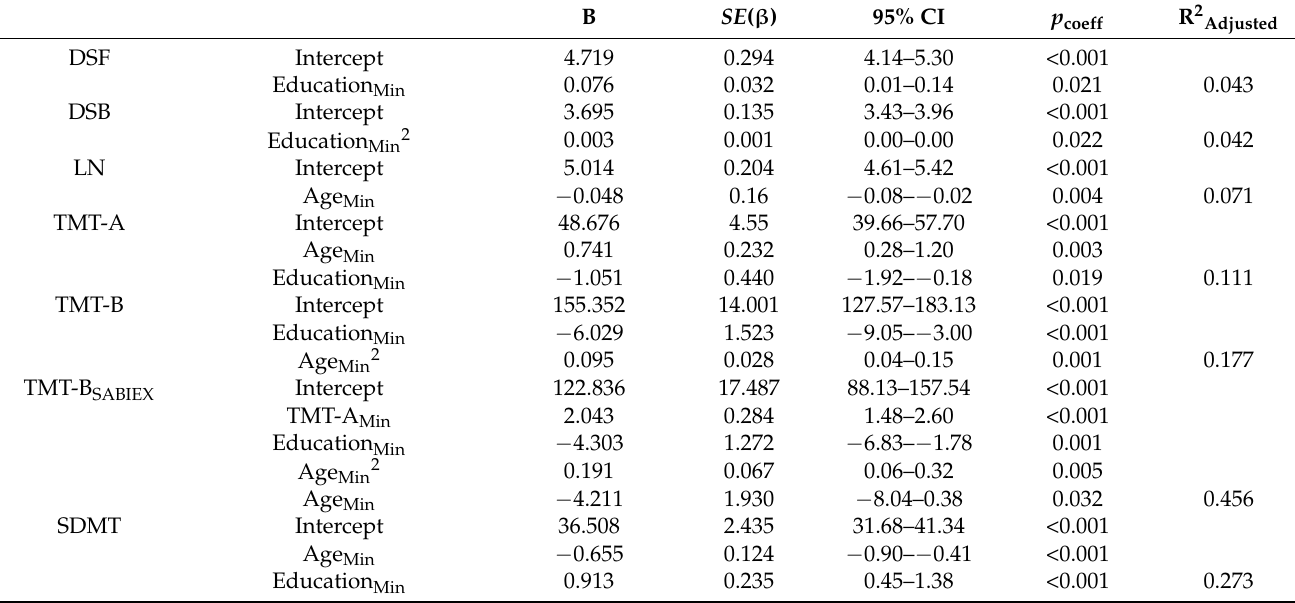
Table 4. Multiple linear regression